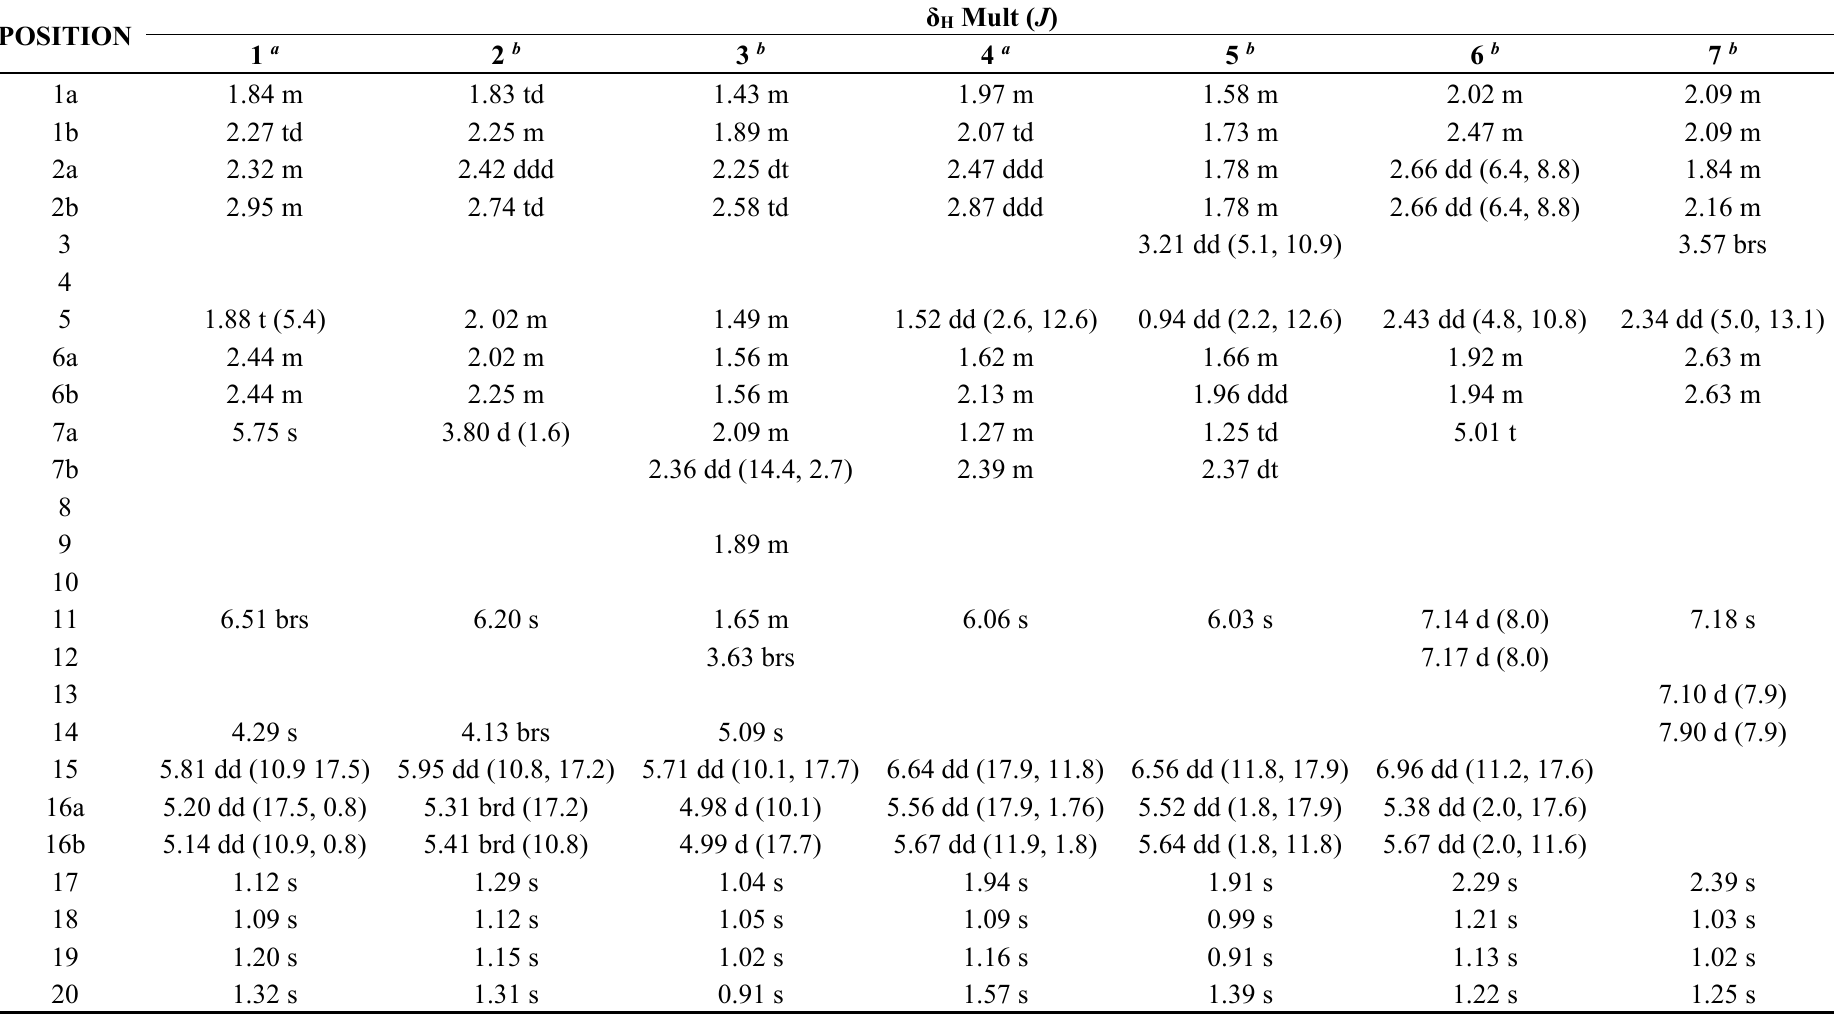
Table 1. 1 H-NMR Data of Compounds 1 − 7